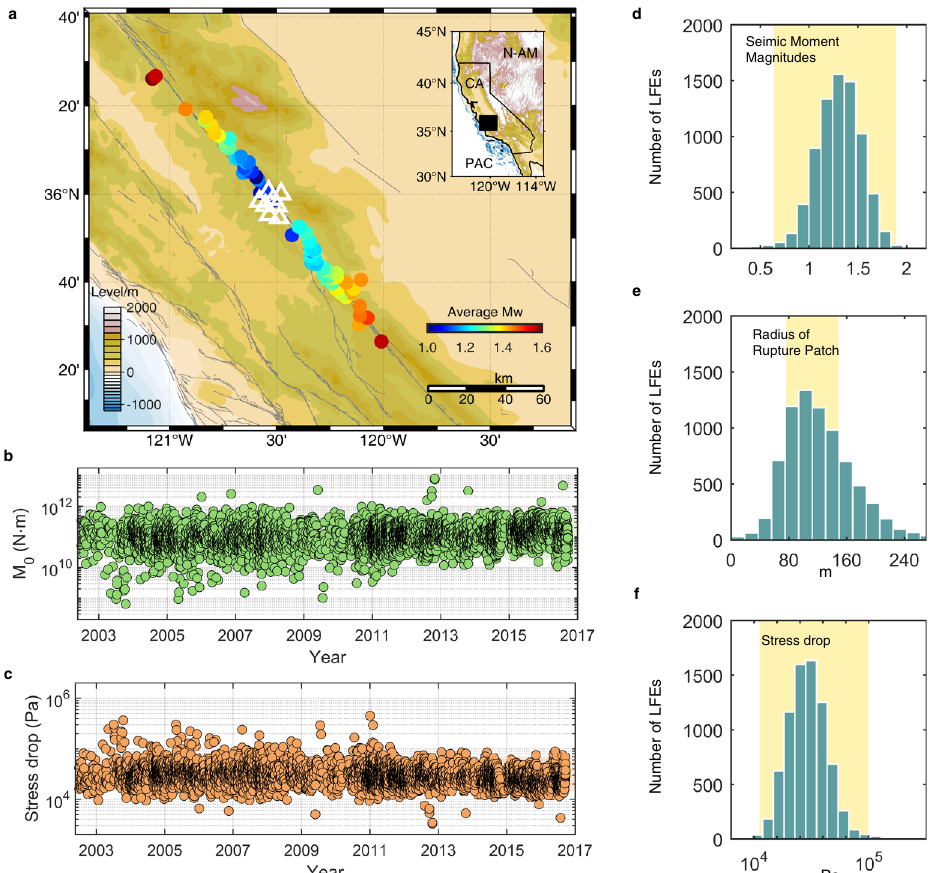
Fig. 2 Park fi eld LFEs. a Map of the Park fi eld, California area, HRSN borehole stations, and associated topography. LFEs identi fi ed by Shelly10 are shown as circles, and the HRSN borehole stations are shown as white triangles. Different circle colors represent different average moment magnitudes of LFEs. b Seismic moment magnitudes of LFEs in Park fi eld (green dots). c Stress drop magnitudes of LFEs in Park fi eld (orange dots). d Histogram of estimated LFE moment magnitudes. The yellow strips show the source parameters range we used in comparison with the simulated results. e Histogram of estimated radii of rupture patches of LFEs. f Histogram of estimated stress drops of